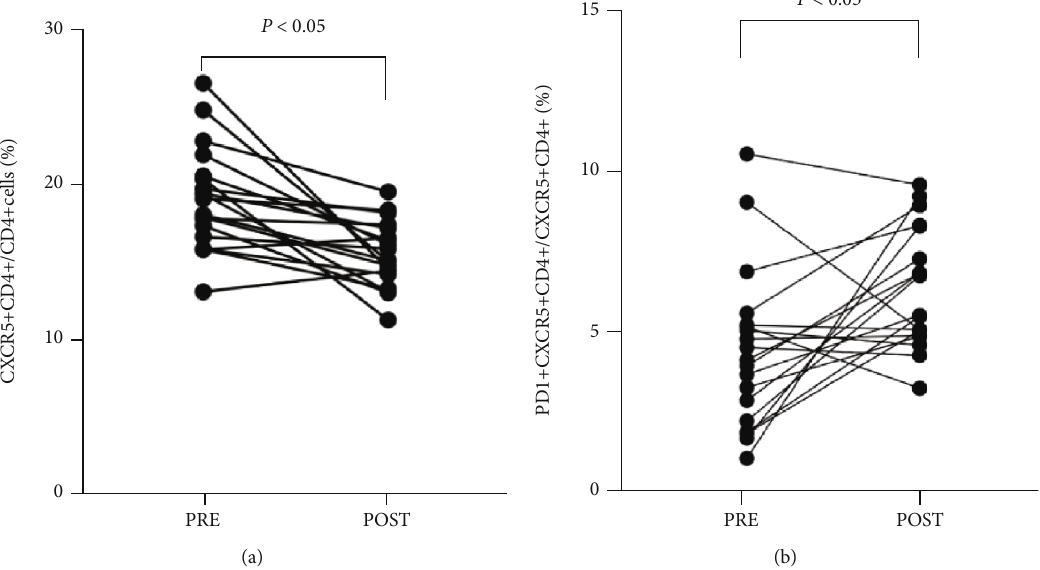
Figure 3: The change of CD4 + CXCR5 + lymphocytes from newly diagnosed MDS-AI (PRE) and posttherapy (POST). (a) The quantity of CD4 + CXCR5 + lymphocytes from newly diagnosed MDS-AI (PRE) and posttherapy (POST) ( n = 19 ). (b) The PD1 expression of CD4 + CXCR5 + lymphocytes from newly diagnosed MDS-AI (PRE) and posttherapy (POST) ( n = 19